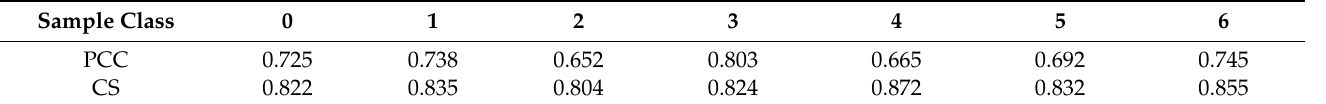
Table 4. PCC and CS values calculated for seven types of generated